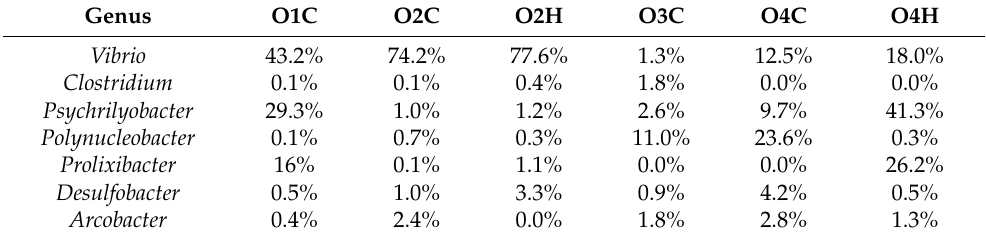
Figure 5. Genus distribution of microbiome of oysters. O4H: hemolymph in spring; O4C: edible portion in spring; O3C: edible portion in winter; O2H: hemolymph in autumn; O2C: edible portion in autumn; O1C: edible portion in summer. Table 7. Genus composition (in percentage) of edible portion and hemolymph during all seasons.